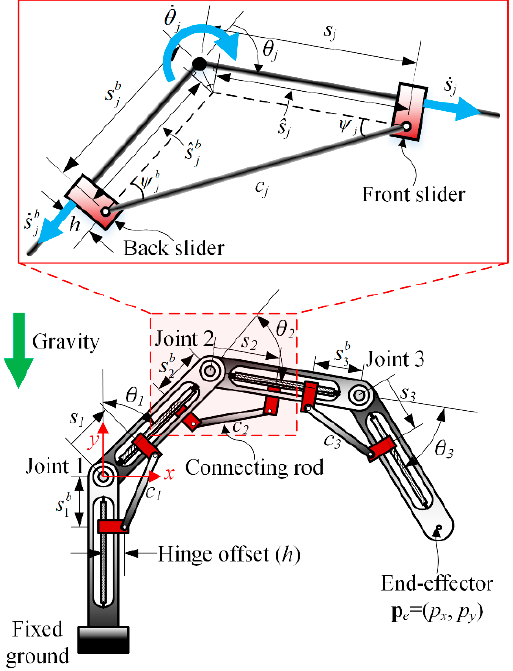
Figure 2. A three-link planar manipulator equipped with the distributed actuation mechanism un- der the effects of gravity [24].